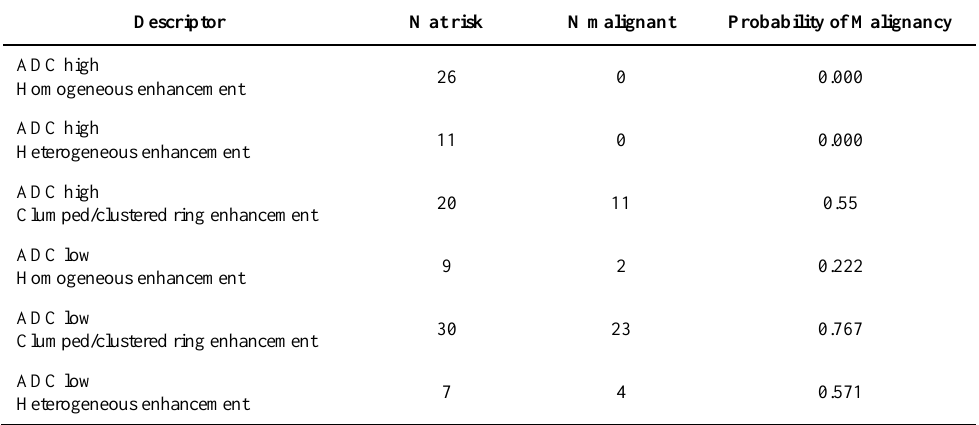
Table 5. Prediction probabilities for malignancy for the combination of enhancement patterns and ADC